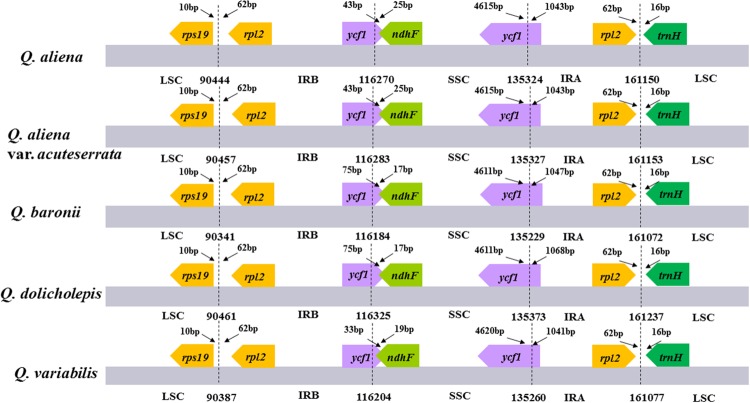
The comparison of the LSC, IR, and SSC border regions among the five Quercus chloroplast genomes. Number above the gene features means the distance between the ends of genes and the borders sites. These features are not to scale.